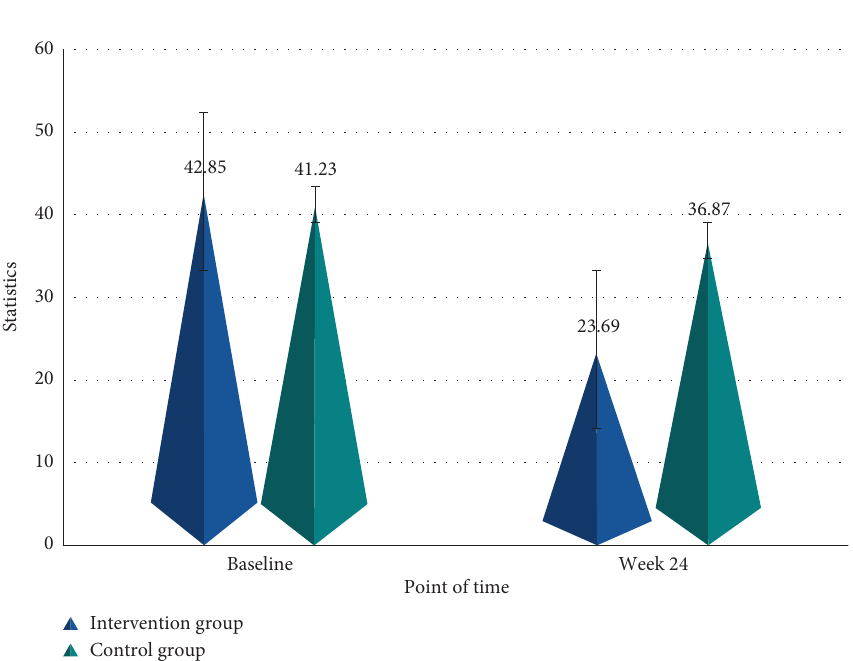
Figure 2: Comparative analysis of upper limb dysfunction between the two groups.